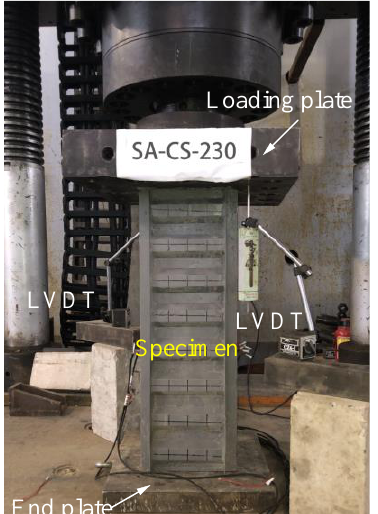
Figure 4. Test and measuring equipment.